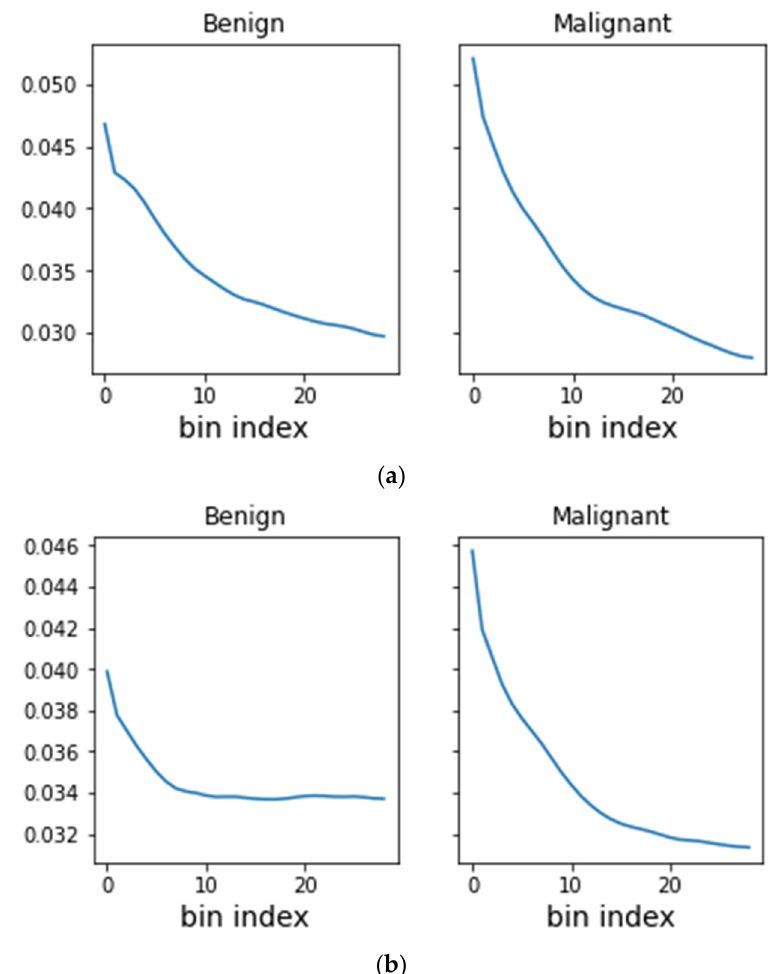
Figure 4. Mean radiographic and contrast density of benign and malignant findings as a function of distance from the calculated center of mass. Averaging across all CEM findings on ( a ) density images and ( b ) contrast images, malignant lesions demonstrated a higher concentration of mammographic density and intravenous contrast near the center of mass than benign